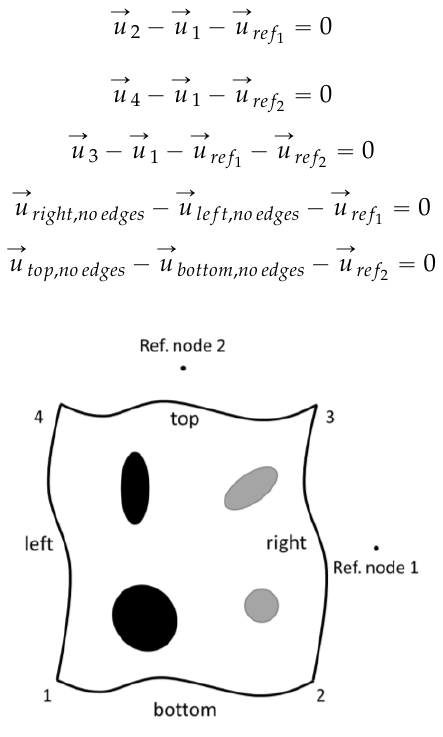
Figure 5. Applying periodic boundary conditions to a microscale RVE.